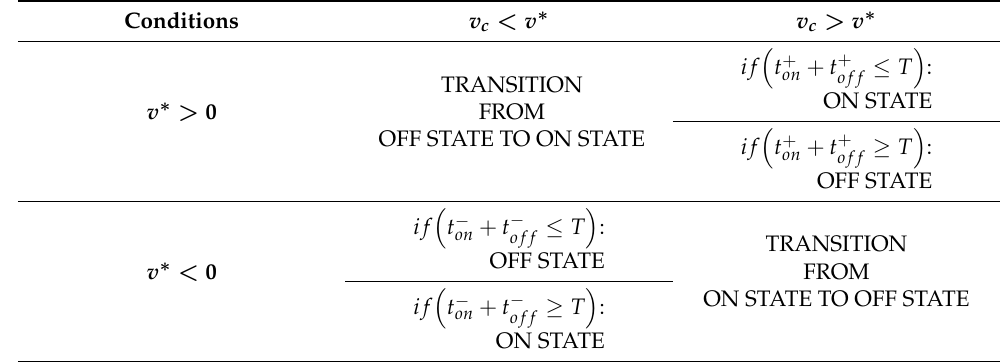
Table 1. Switching logic for generating gating pulses.